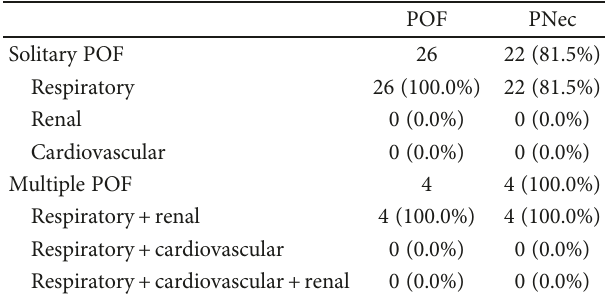
Table 2: Types of POF and the corresponding pancreatic